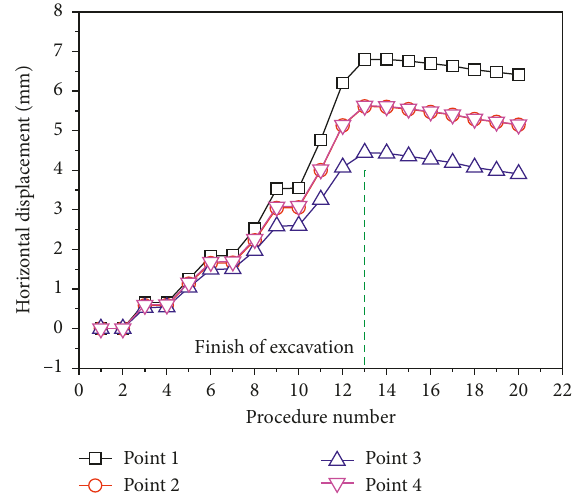
Figure 15: Horizontal displacement of the tunnel structure in scheme 3. Table 8: Deformation values of the tunnel structure. Scheme